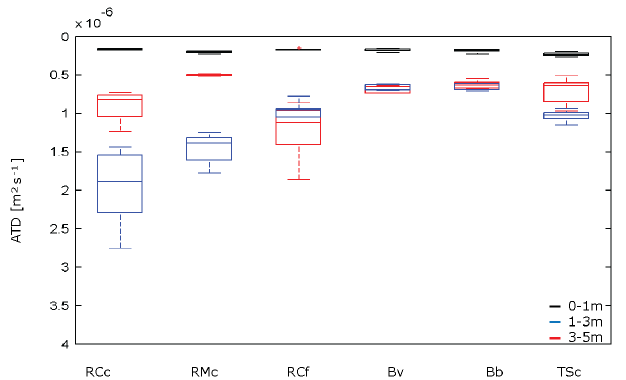
Fig. 10. ATD of the different sites. Calculated for the surface (black), the active layer (blue) and for the permafrost body (red).